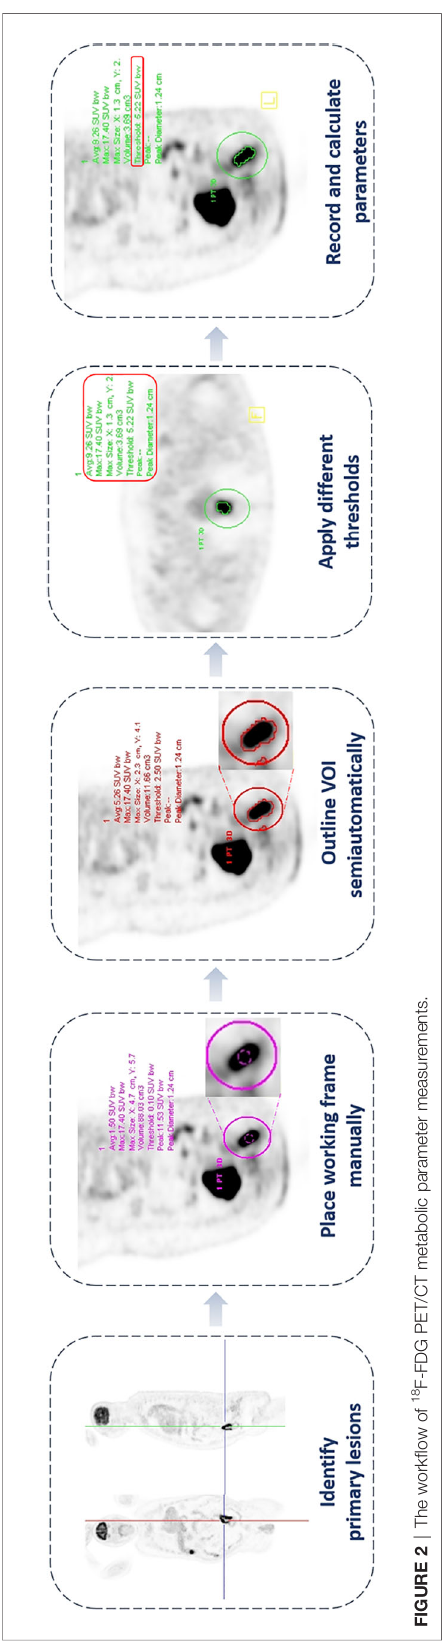
Figure 5 . For clinical parameters, the AUCs of age and tumor F